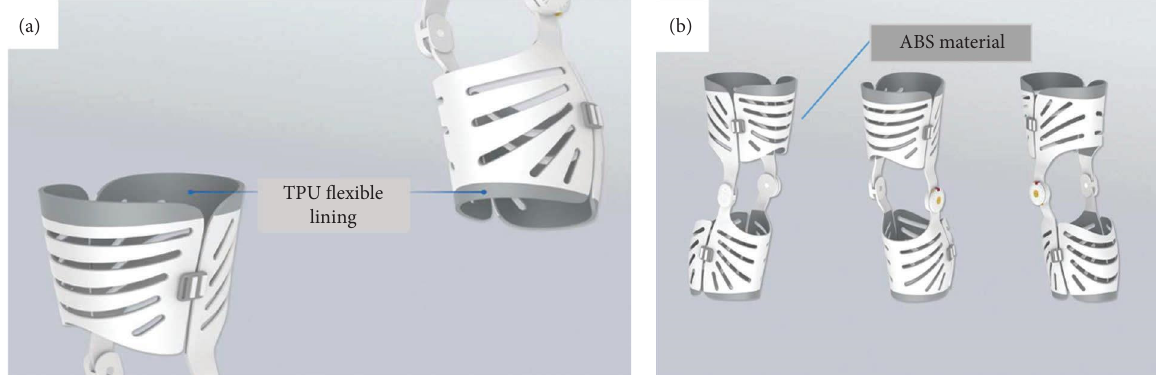
Figure 11: Knee orthoses. (a) TPU material was used on the inside; (b) ABS material was used on the outside. Table 3: Four kinds of material printing AFO real-world printing special point.